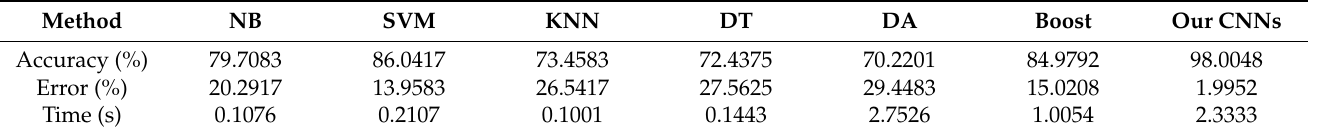
Table 4. Comparison of recognition results by different algorithms (mean value).